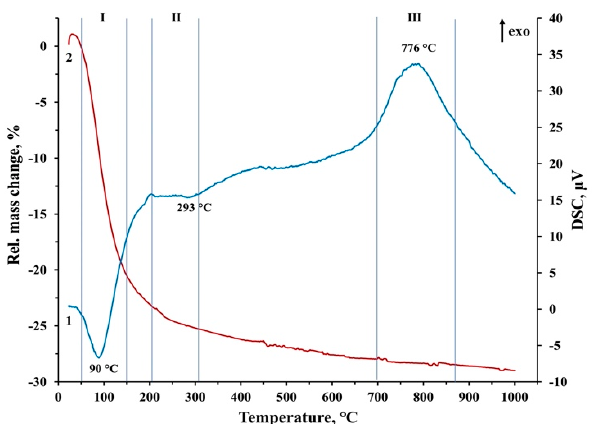
Figure 2. DSC (1) and TG (2) curves of the precursor (P).